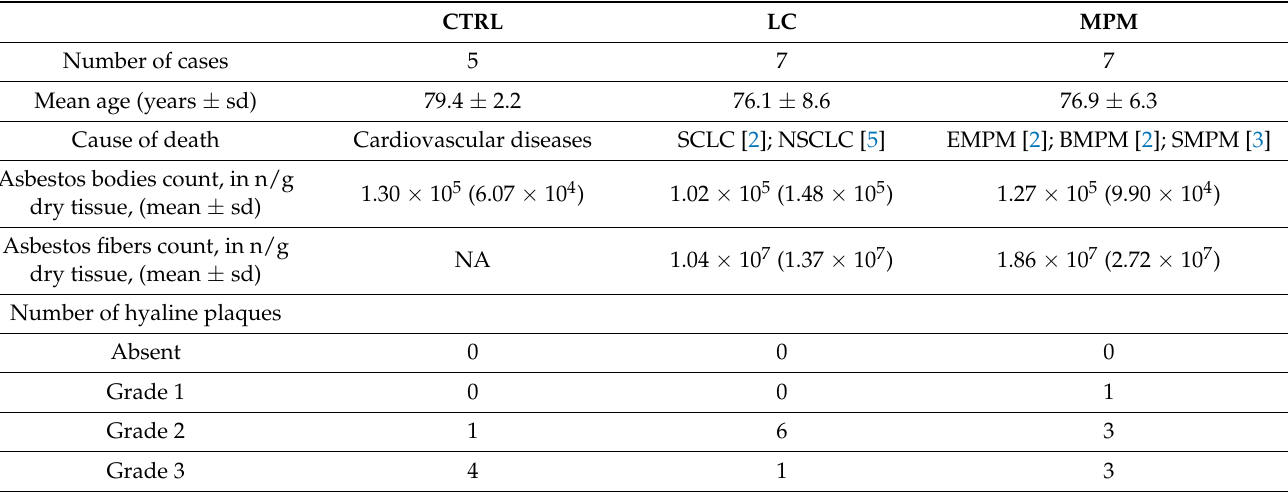
Table 1. Clinicopathological characteristics of control, lung cancer and malignant pleural mesothe- lioma populations. CTRL